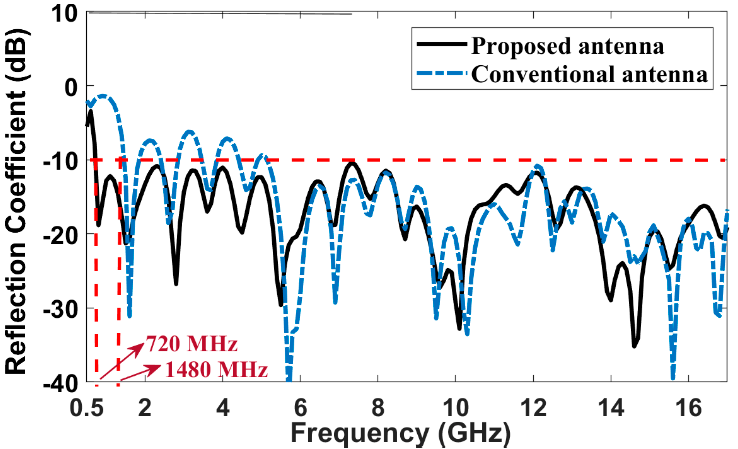
Figure 4. Reflection coefficient of the AVA (Antipodal Vivaldi antenna) structure with arms (proposed antenna) and without arms (conventional antenna).